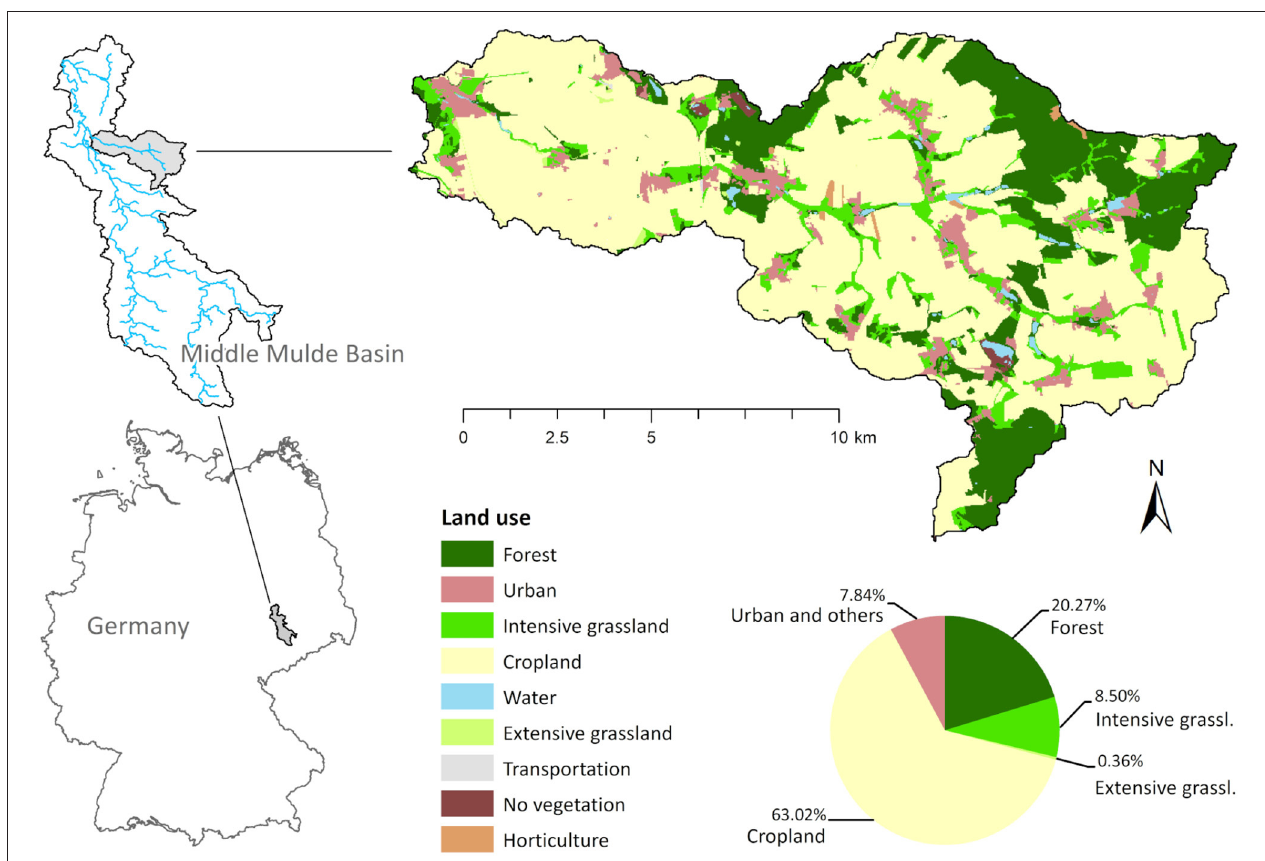
FIGURE 2 | Location, land use map, and land use distribution of the Lossa River